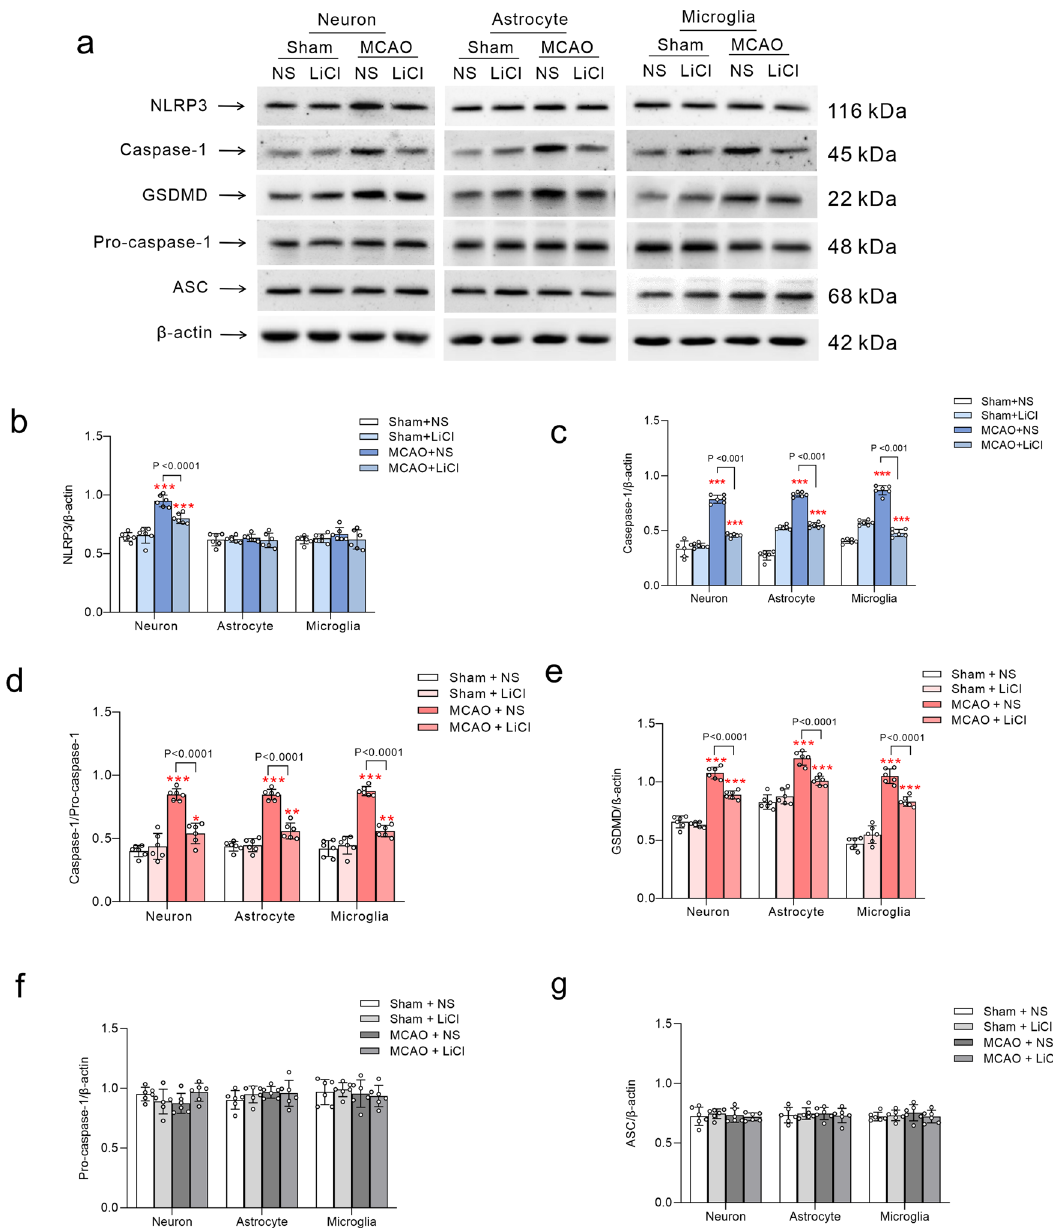
Fig. 2 Li + suppresses expressions of NLRP3 and GSDMD induced by ischaemia-reperfusion. Cortices of Thy1-YFP and GFAP-GFP transgenic mice were used for isolating and FACS sorting neurones and astrocytes, respectively, for FACS sorting of microglia the cells from cortex of wild-type mice were labelled with Iba1. a The representative protein bands of NRLP3, caspase-1, GSDMD, pro-caspase-1, ASC and β -actin (the house-keeping protein) in neurones, astrocytes and microglia. b – g Normalised intensities of NLRP3, caspase-1, GSDMD, pro-caspase-1 and ASC by β -actin and the ratio of caspase-1 and pro-caspase-1 are presented as mean ± SD. N = 6 per group. One-way ANOVA for comparisons including more than two groups; unpaired two-tailed t -test for two group comparisons. * p < 0.05, ** p < 0.01, *** p <